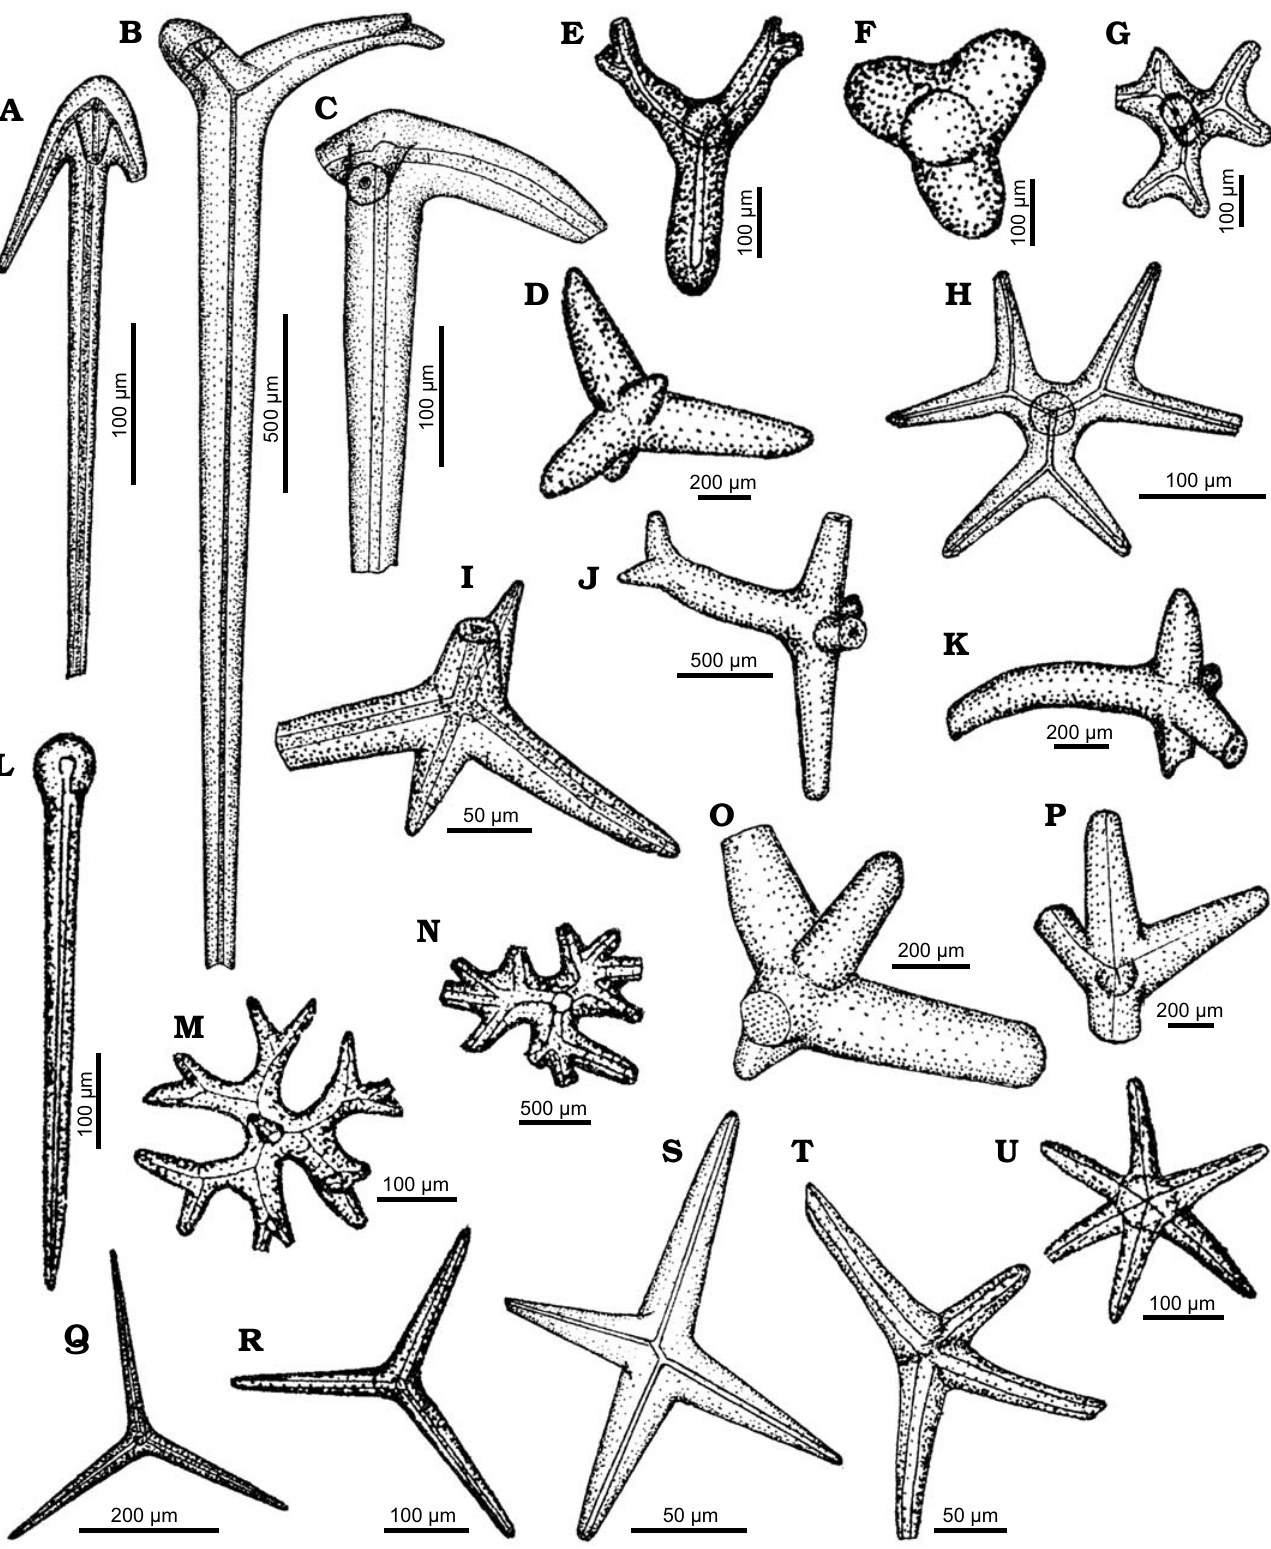
Fig. 3. Spicule morphotypes from south-central Ukraine; Č ernoleska, upper Eocene (A), Pes č anoe, upper Eocene (B), Russkie Ti ŝ ki, middle Eocene (C, I, Q), Verhnee, lower Eocene (D, F, H, J, K, O, P), Nikol’skoe, upper Eocene (E, L), Staroverovka, middle Eocene (G), Markovka, upper Eocene (M), Kiselevka, lower Eocene (N), Grigorevka, middle Eocene (R), Kiselevka, middle Eocene (S), Markovka, middle Eocene (T), and Pes č anoe, upper Eocene (U). A , C . Anatriaenes. B . Orthodichotriaene. D , I – K , O , P . Mesotriaenes. E . Prodichotriaene. F , T . Calthrops. G , H . Dichotriaenes. L . Tylostyle. M , N . Mesodichotriaenes. Q , R . Triods. S . ?Plesiaster. U . Oxyaster. After Ivanik (2003);